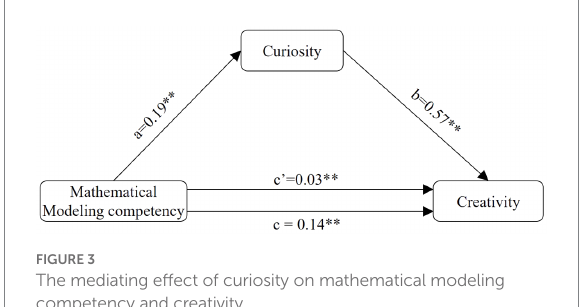
FIGURE 3 The mediating effect of curiosity on mathematical modeling competency and creativity.